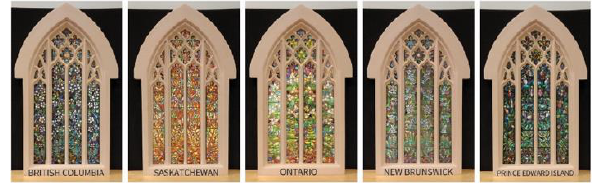
Figure 7: Image targets with dark background and text